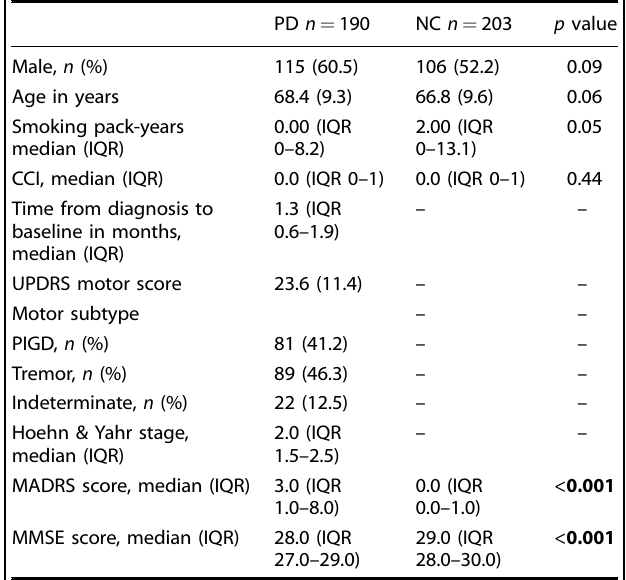
Table 2. Clinical milestones as time-dependent covariate risk factors and time to death.